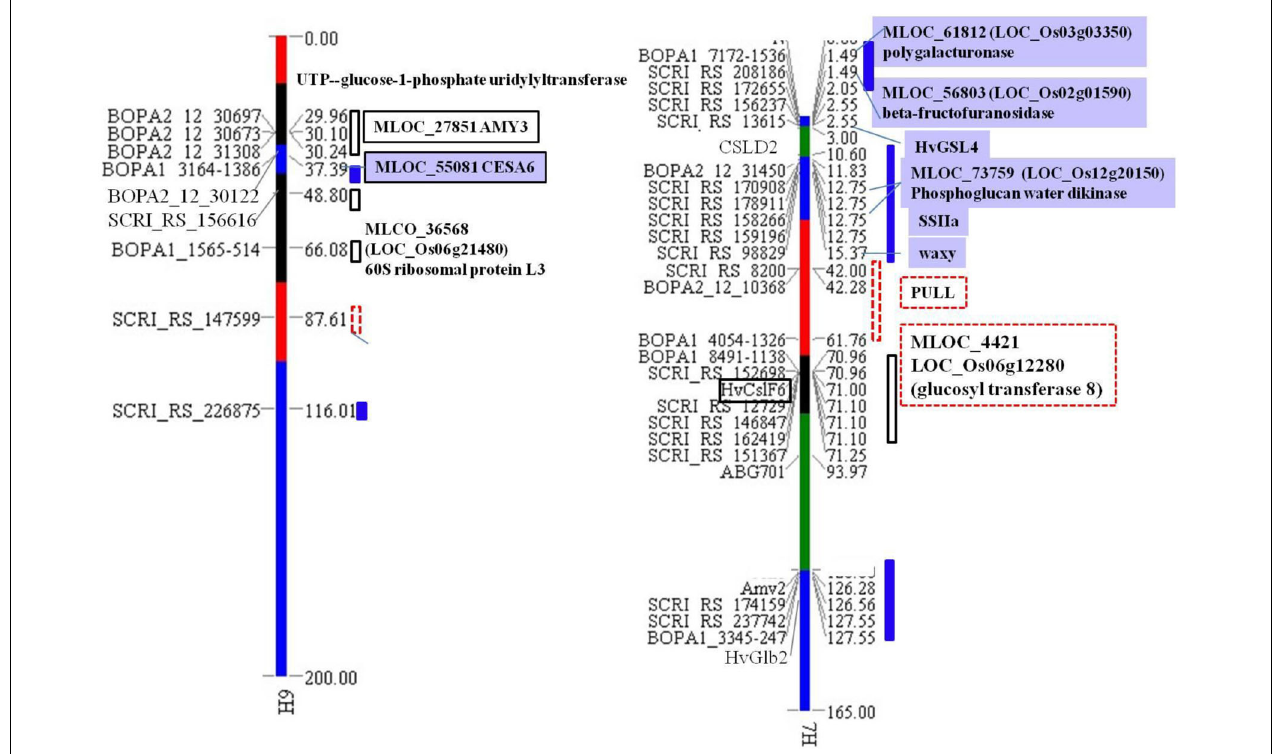
FIGURE 3 | Major SNPs for amylose, amylopectin and β -glucan and their orthologous genes or close genes. SNPs regions responsible for β -glucan are indicated by a solid box, for amylose are indicated by a dashed box, and for amylopectin are indicated by a bar. The candidate genes were boxed with